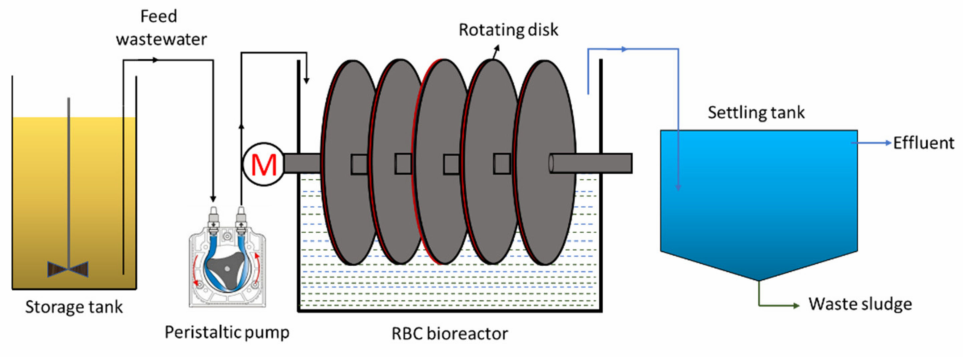
Figure 1. Schematic diagram of RBC